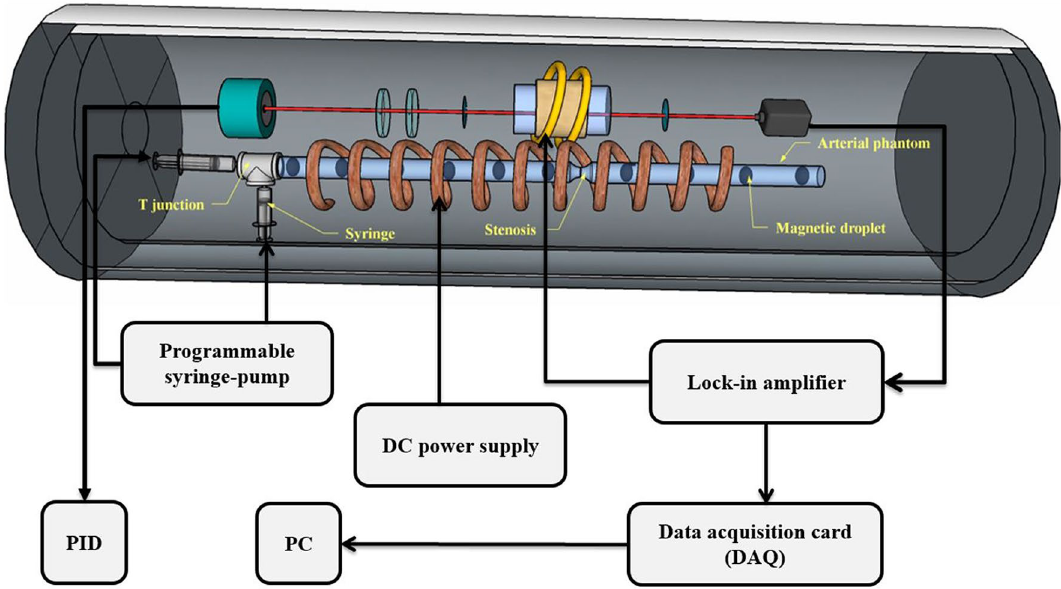
Figure 2. Experimental setup for detecting the magnetic